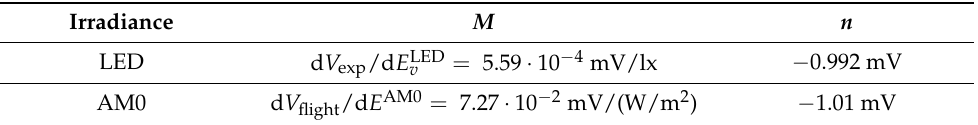
Table 3. Coefficients of the slope, m , and offset, n , obtained from the linear fittings to the expected response of the SS1-X+ photodiode under LED and AM0 irradiance (see also Figure